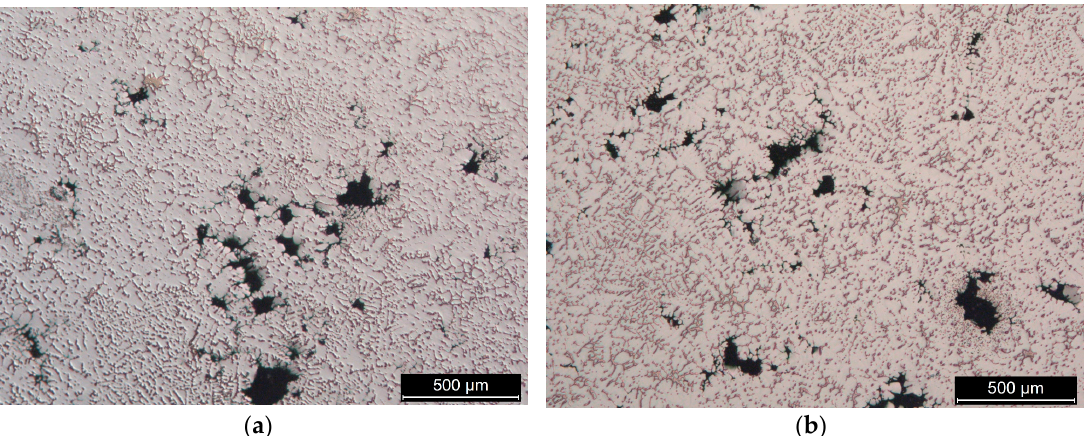
Figure 8. The produced Al–Cu alloy samples from ( a ) batch 15M and ( b ) batch 45M, both without chemical etching.